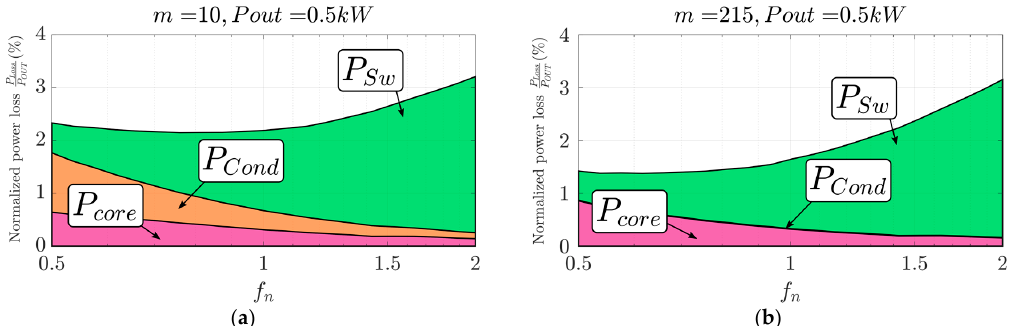
Figure 6. LLC converter total normalized power losses ( P Loss / P OUT ) at 500 W output power, including primary and secondary transistors and a transformer; ( a ) for m = 10; ( b ) for m = 15 .